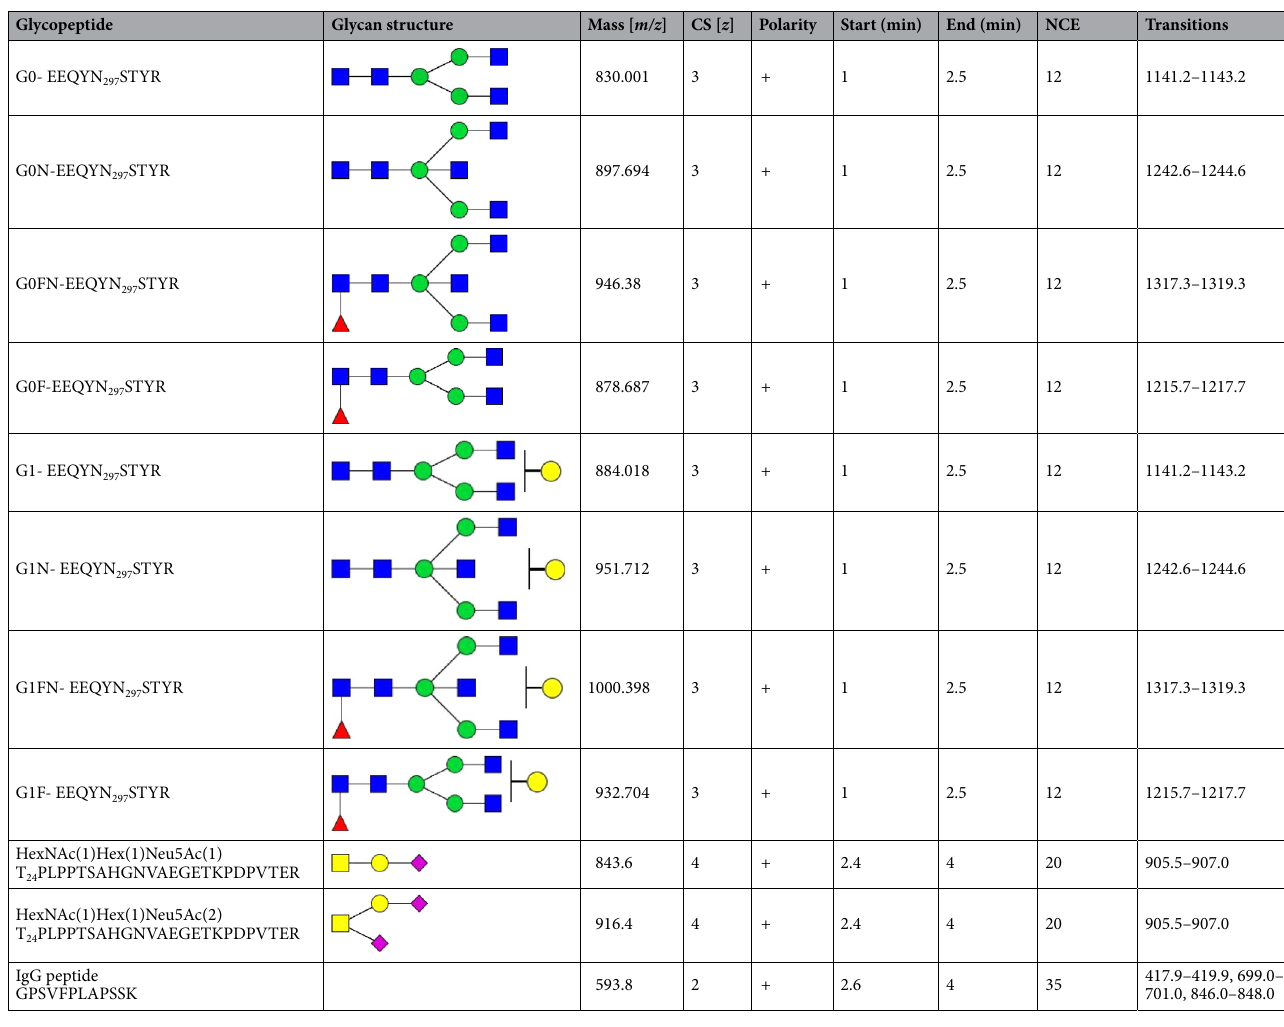
Table 1. MS data collection parameters for a targeted PRM analysis, and the transitions used for quantitation of the tryptic glycopeptides of IgG and HPX. *HexNAc: blue rectangle (GlcNAc), yellow rectangle